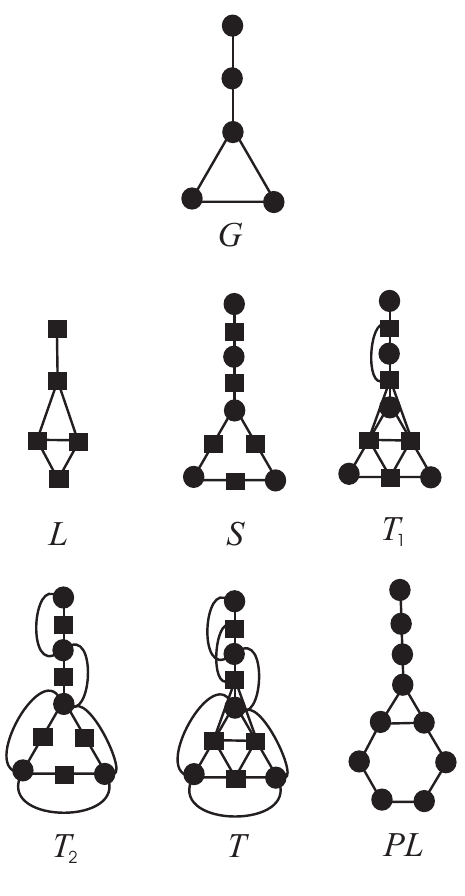
Fig. 1. Various graphs derived from the graph G . The vertices of these derived graphs (except the paraline graph P L ), corresponding to the vertices of the parent graph G , are indicated by circles. The vertices of these graphs, corresponding to the edges of the parent graph G are indicated by